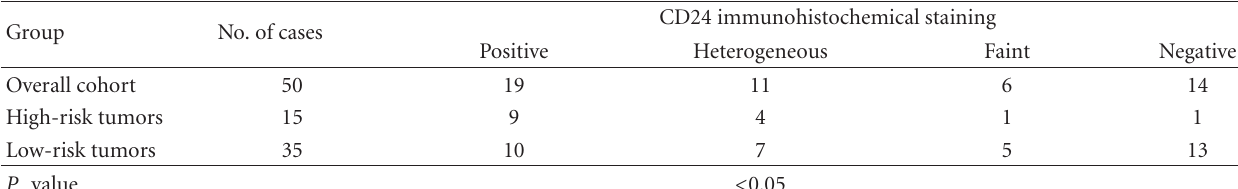
Table 1: The expression of CD24 protein in high-risk and low-risk retinoblastoma. Group